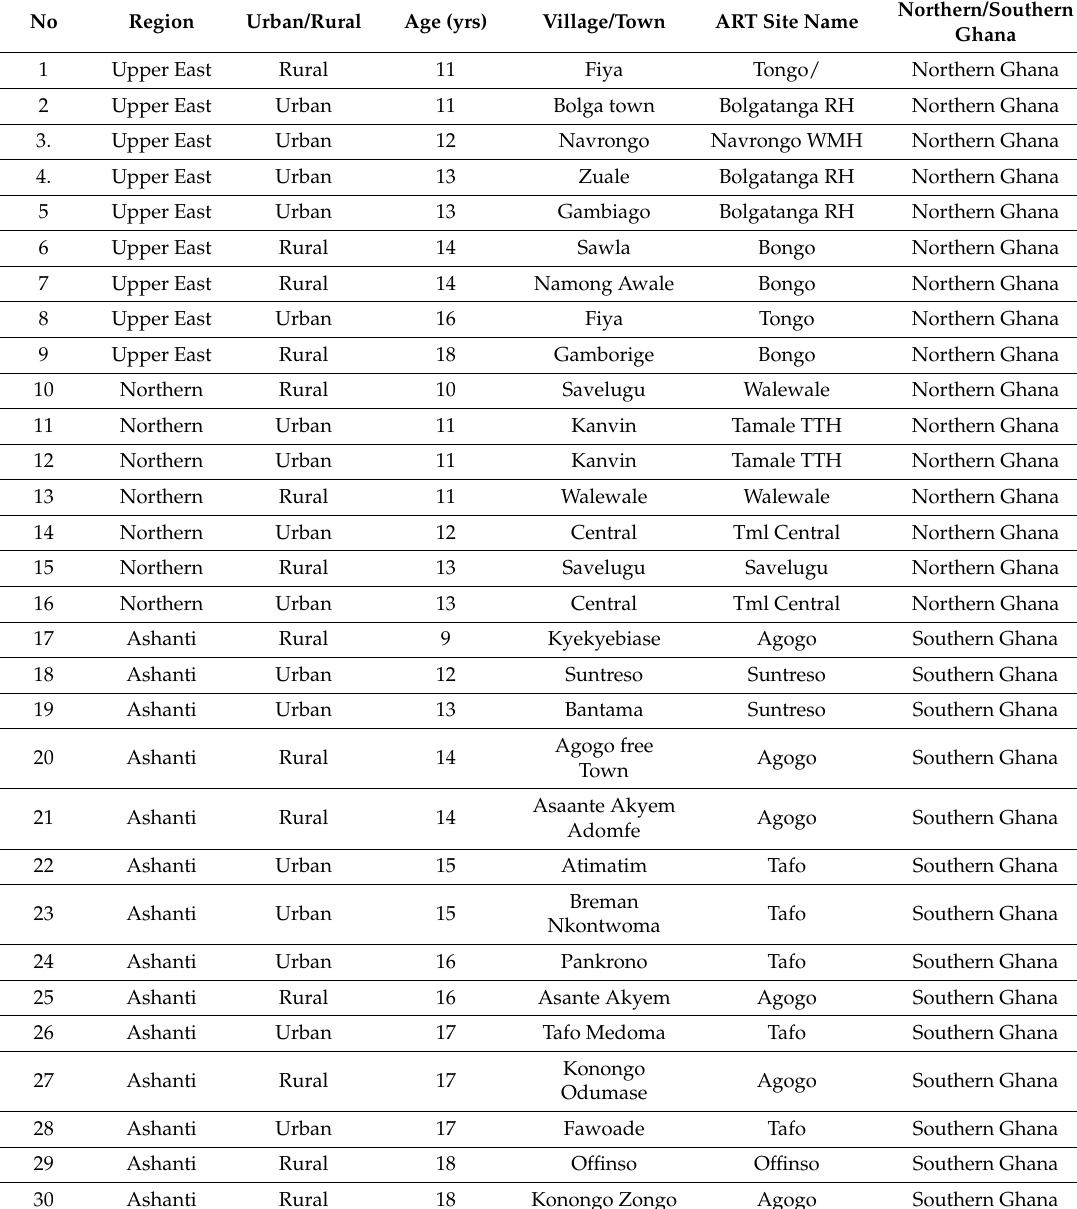
Table 1. Child age, geographical setting and